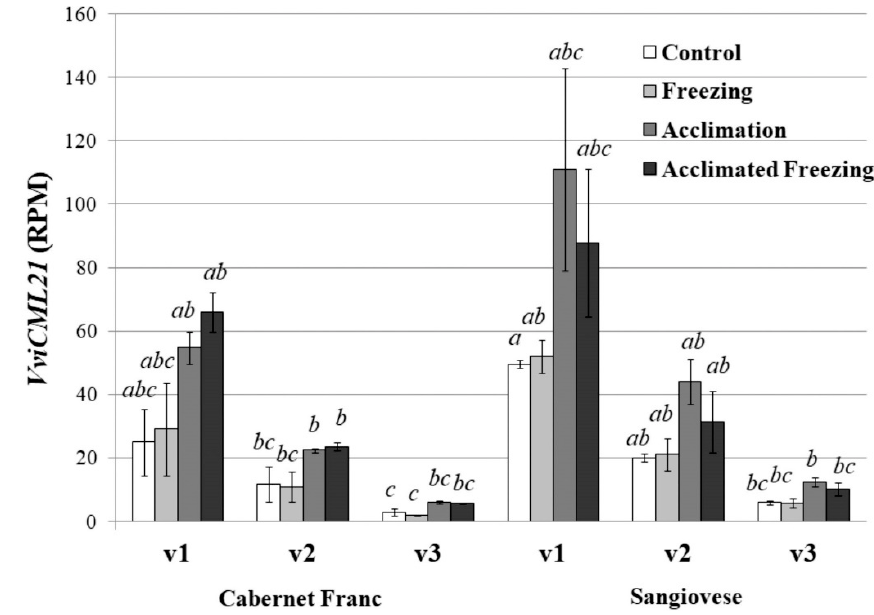
Figure 3. Expression levels of the CML21v1 , CML21v2 , and CML21v3 splice variants in Vitis vinifera in the most-damaged cultivar “Cabernet Franc” and the least-damaged cultivar “Sangiovese” cultivated under low-temperature stress conditions. The RNAseq libraries were obtained by Londo et al. [37] and analyzed in the present study for VviCML21 abundance. The V. vinifera plants were exposed to control treatment, freezing (gradual freezing to − 3 °C for 45 min), acclimation or chilling (+4 °C for 48 h), and acclimated freezing (+4 °C for 48 h and − 3 °C for 45 min). RPM—reads per million mapped reads. The data are presented as the mean ± SE. Means followed by the same letter were not different using one-way analysis of variance (ANOVA), followed by the Tukey HSD multiple comparison test. A value of p ≤ 0.05 was considered significant.